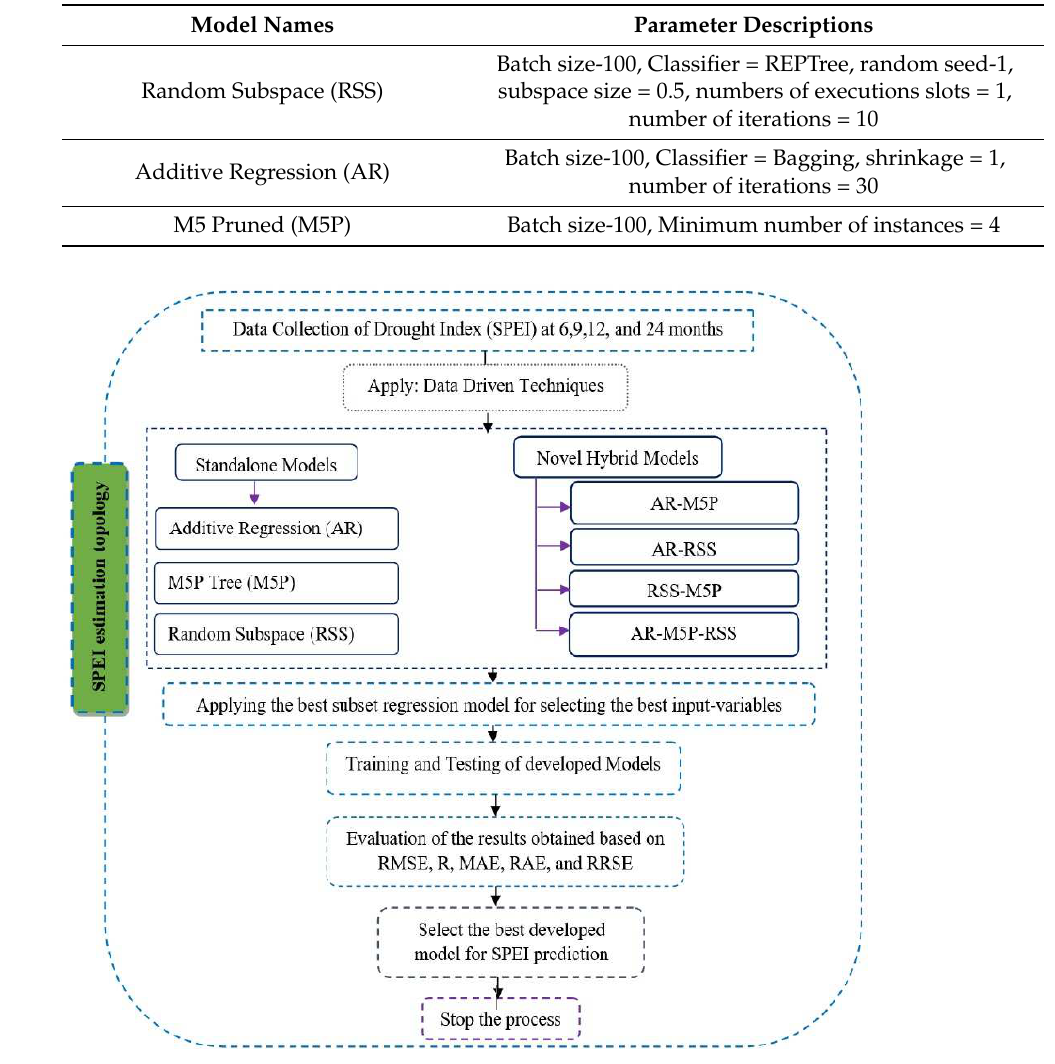
Figure 2. Flowchart of SPEI estimation methodology in the study area. Table 2. The parameters of the machine learning algorithm in modeling SPEI-6, -9, -12 and -24.